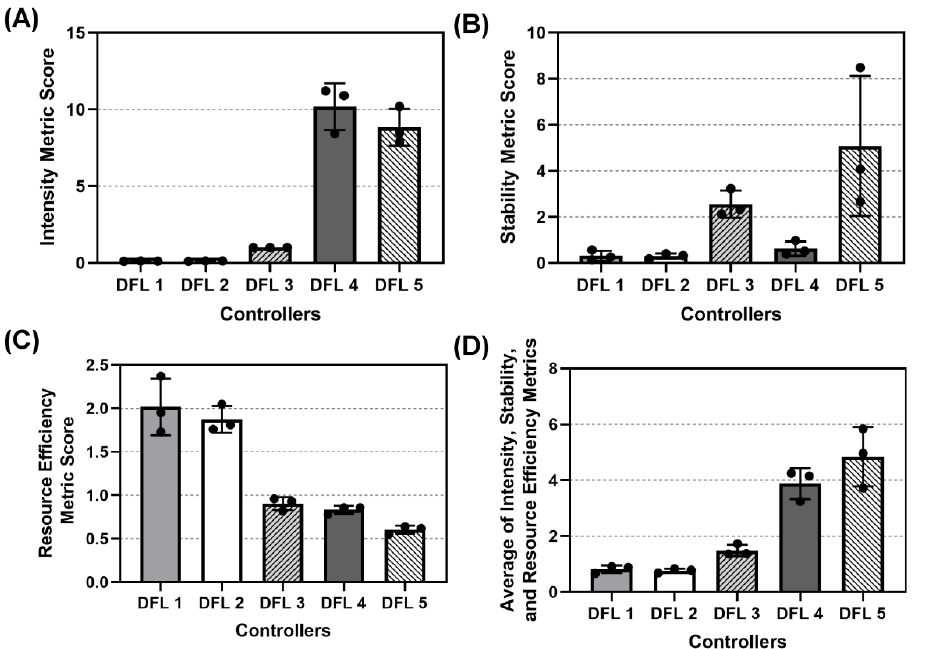
Figure 8. Aggregate metric results for dual-input fuzzy logic controller configurations. Aggregate ( A ) Intensity, ( B ) Stability, ( C ) Resource Efficiency, and ( D ) Average across the three metric results are shown as mean values from three subject variability runs, with error bars denoting standard deviation.